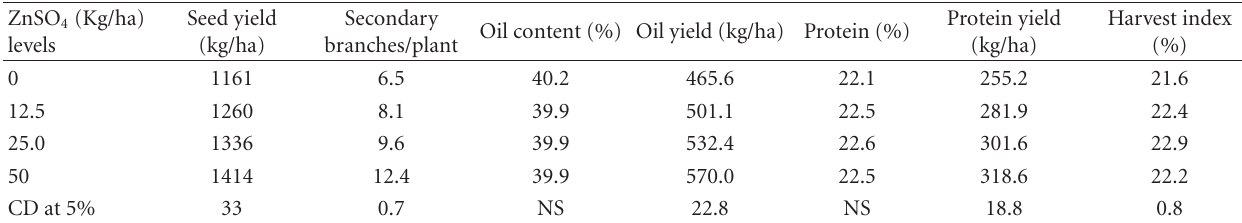
Table 8: E ff ect of Zn on yield and yield attributes of indian